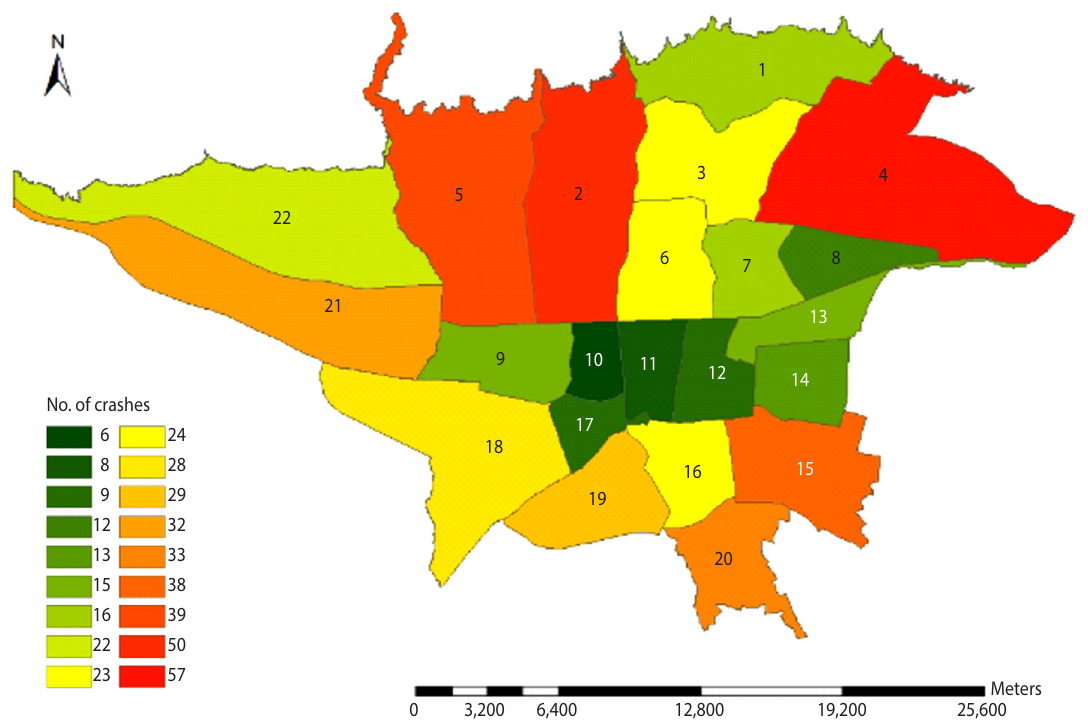
Figure 2. Distribution of studied traffic collisions in Tehran based on separate urban areas during April 2014 to March 2017.